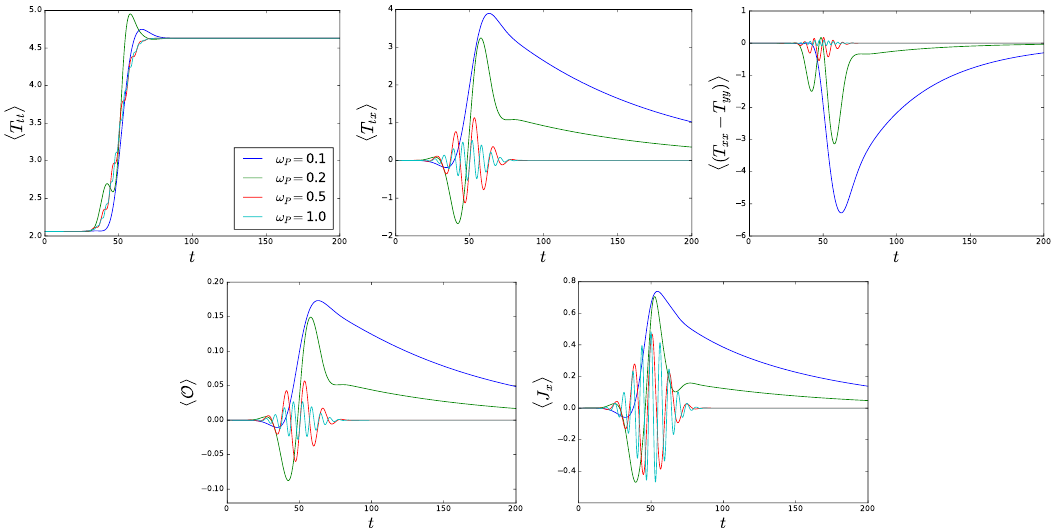
Figure 6 . Plots of expectation values of one point functions for di(cid:11)erent pump frequencies ! P = (0 : 1 ; 0 : 2 ; 0 : 5 ; 1 : 0). Again (cid:22) I = 1 ; T I = 0 : 2 ; T F = 0 : 3 ; k = 0 : 2 : The plots show the exponential QNM approach to equilibrium, with decreasing amplitudes for increasing ! P